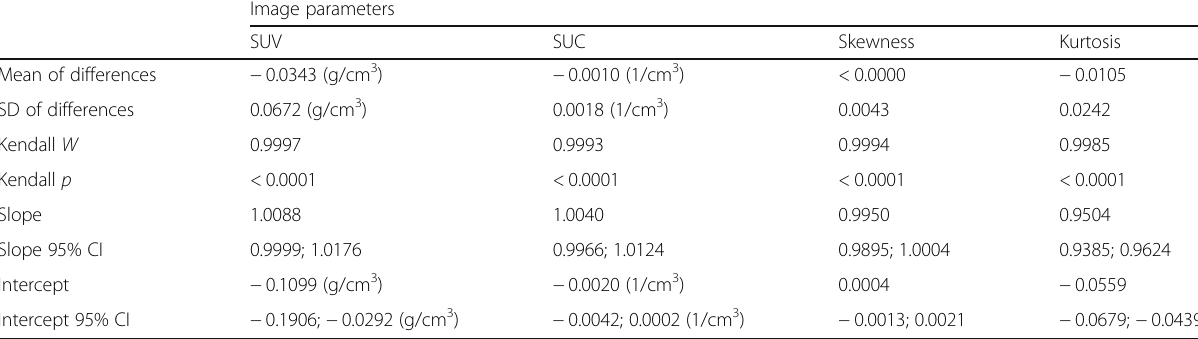
Table 1 Results of the comparison of two researchers ’ segmentations Image parameters SUV